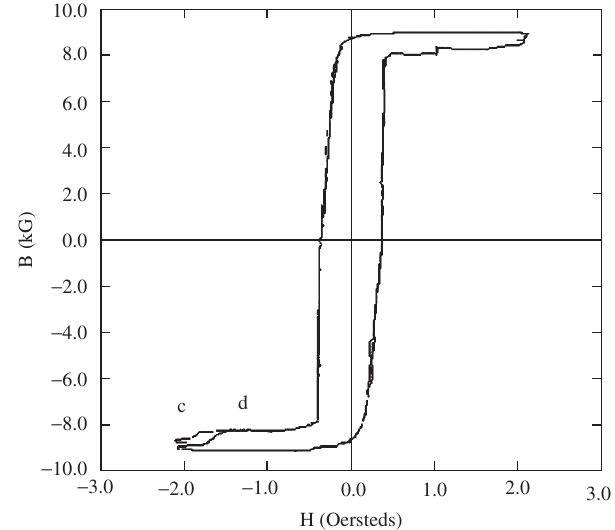
Figure 1. Hysteresis curves of stress annealed samples a and b with diameters of 16 and 25 mm, respectively, at a frequency of 10 kHz.